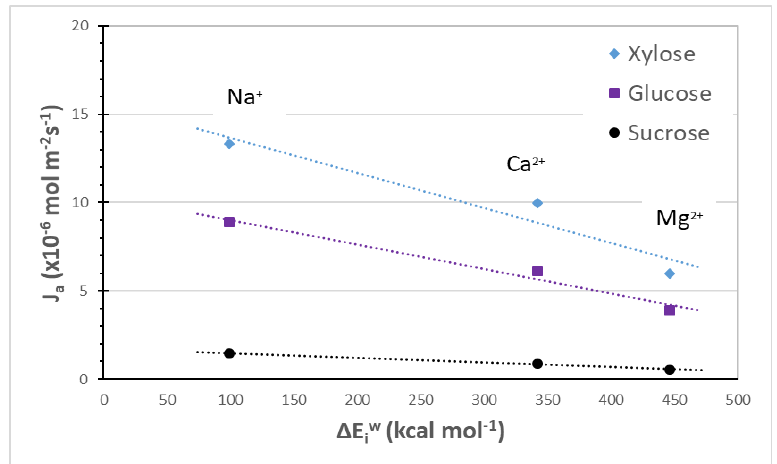
Figure 5. Sugars fluxes through cation exchange membranes (CMX) versus cation hydration energies (Cl − is used as common anion). Sugar fluxes measured in diffusion regime [Sugar] = 1 mol L −1 [electrolyte] = 1equiv. L −1 [6].